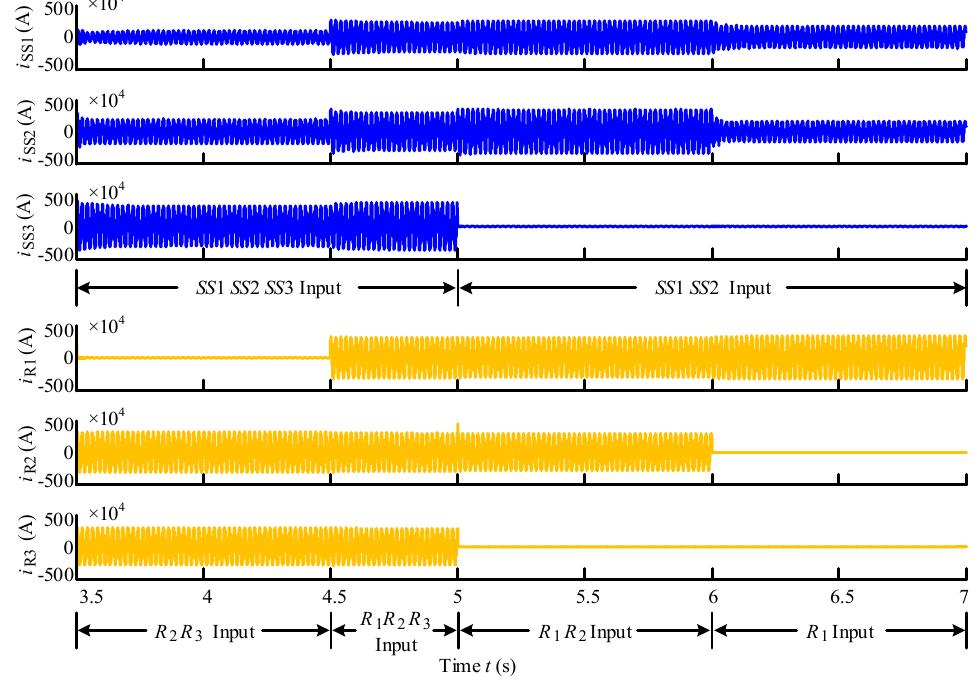
Figure 16. The current waves of the traction substations and locomotives in 3.5 ‒ 7 s.